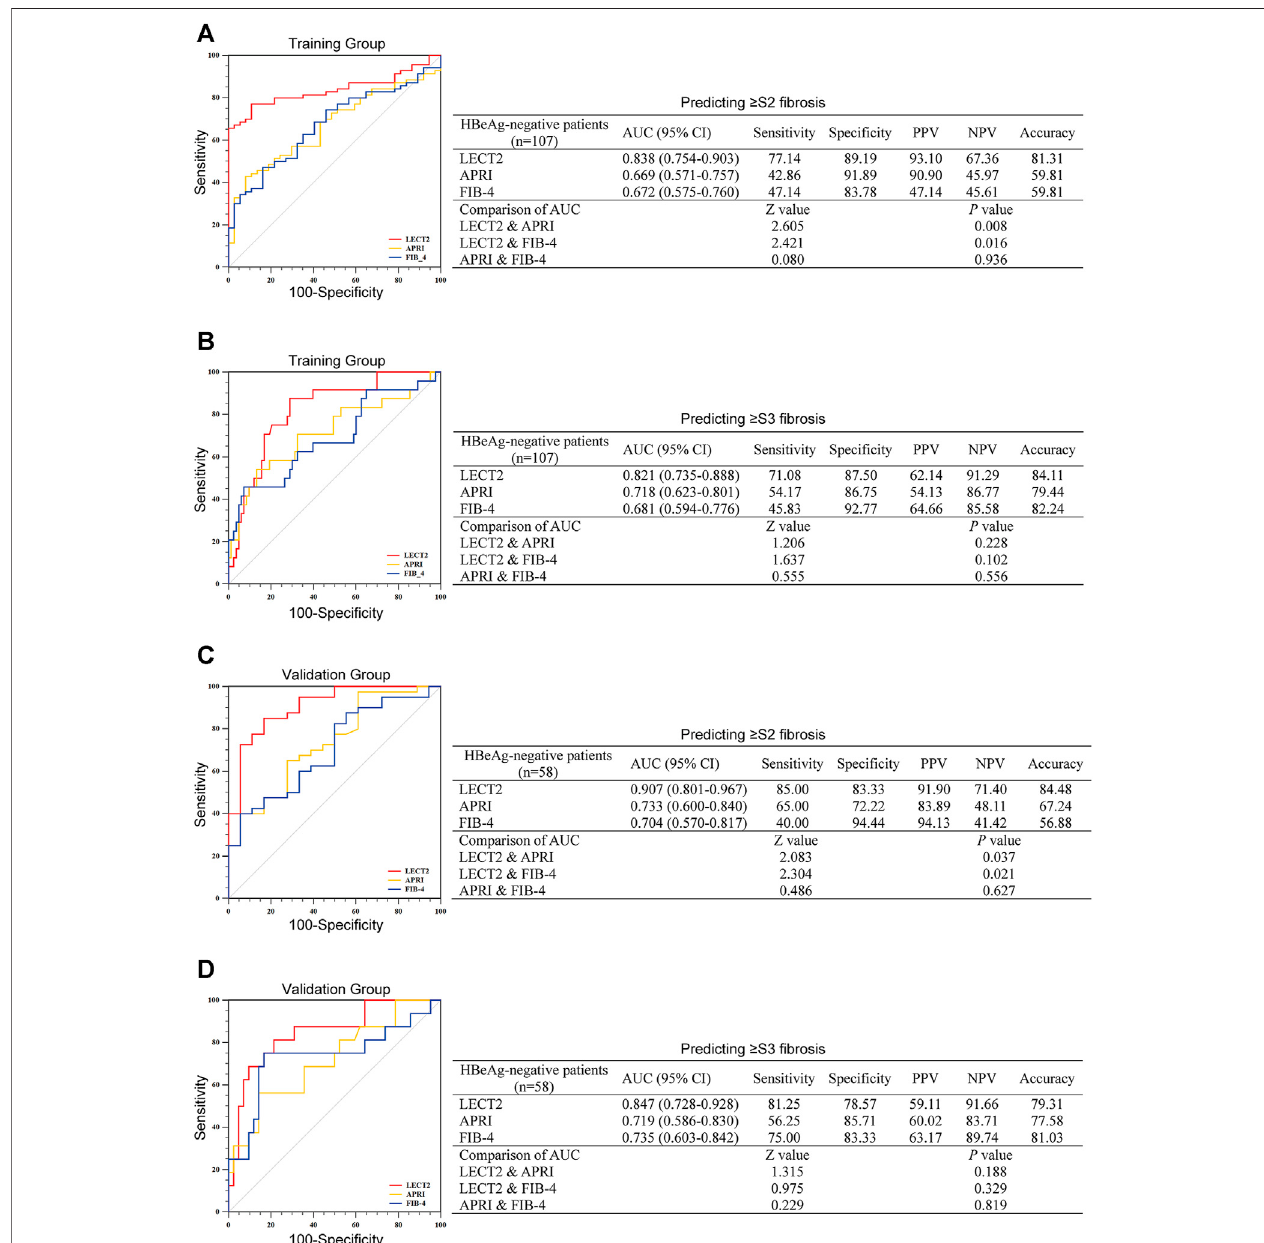
FIGURE 3 | The diagnostic ef fi cacy of LECT2, APRI, and FIB-4 for identifying liver fi brosis in CHB patients with HBeAg-negative. (A,B) Identi fi cation of signi fi cant liver fi brosis( ≥ S2)oradvancedliver fi brosis( ≥ S3)inthetraininggroup. (C) and (D) showthefurtherveri fi cationofthevalidationgrouptothetraininggroup.AUC,thearea under the ROC; PPV, positive predictive value; NPV, negative predictive